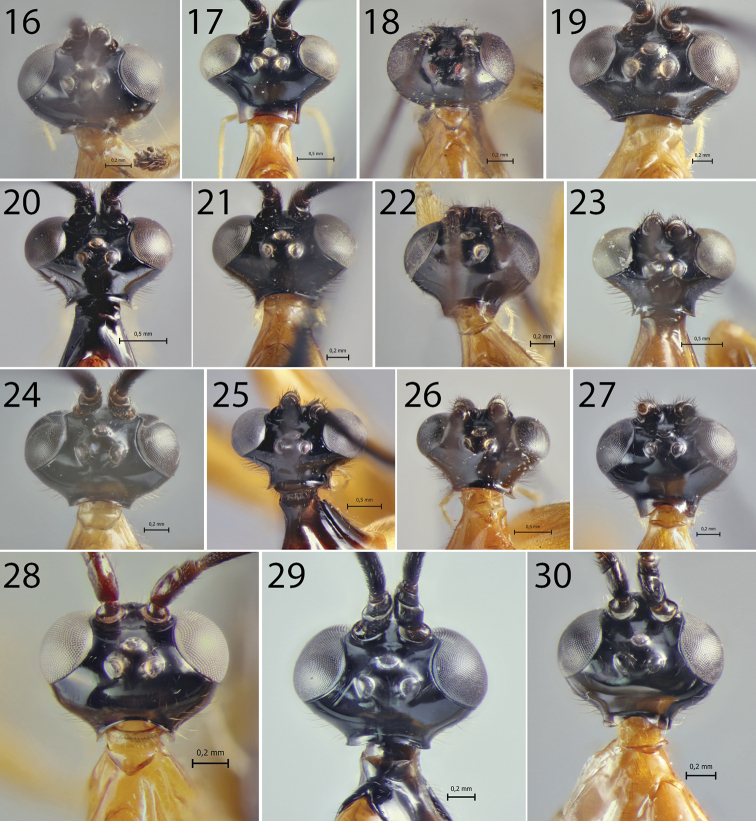
Heads of Hymenoepimecis spp. (females), dorsal view 16H.
andina sp. nov. (holotype) 17H.
bicolor18H.
castilloi sp. nov. (holotype) 19H.
dolichocarinata sp. nov. (holotype) 20H.
duckensis21H.
ecuatoriana sp. nov. (holotype) 22H.
kleini23H.
longilobus sp. nov. (holotype) 24H.
manauara25H.
neotropica26H.
pucallpina sp. nov. (holotype) 27H.
rafaelmartinezi sp. nov. (holotype) 28H.
ribeiroi29H.
tedfordi30H.
uberensis.